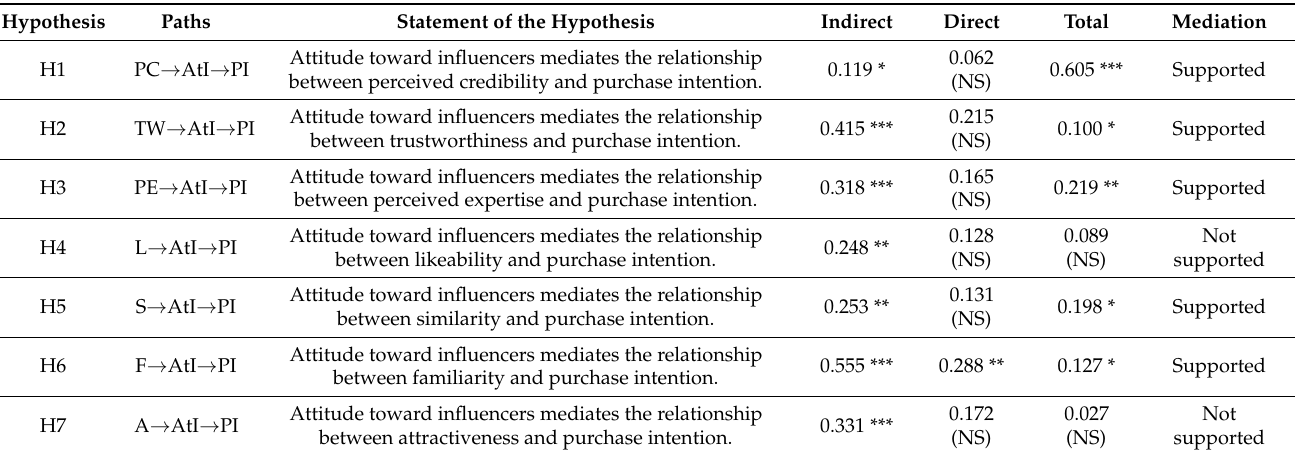
Table 6. Results of the mediation hypotheses (standardized regression